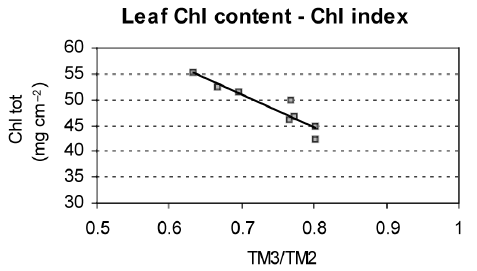
Fig. 9. Linear relationship between «chlorophyll in- dex« (TM3/TM2), calculated on the basis of the TM image, and leaf chlorophyll content. The coefficient of determination ( R 2 ) is equal to 0.87 ( y =− 62.569 x + +